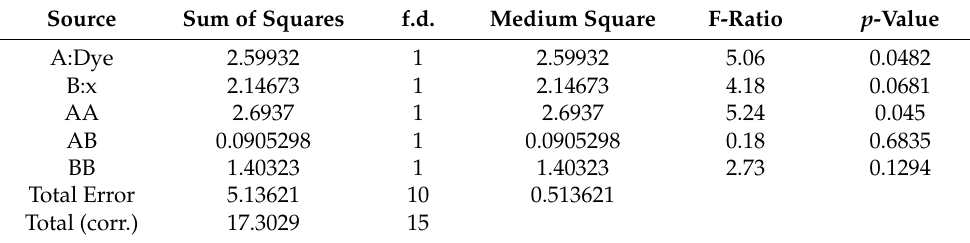
Table 2. Variance analysis for Ads(%) from the 4 2